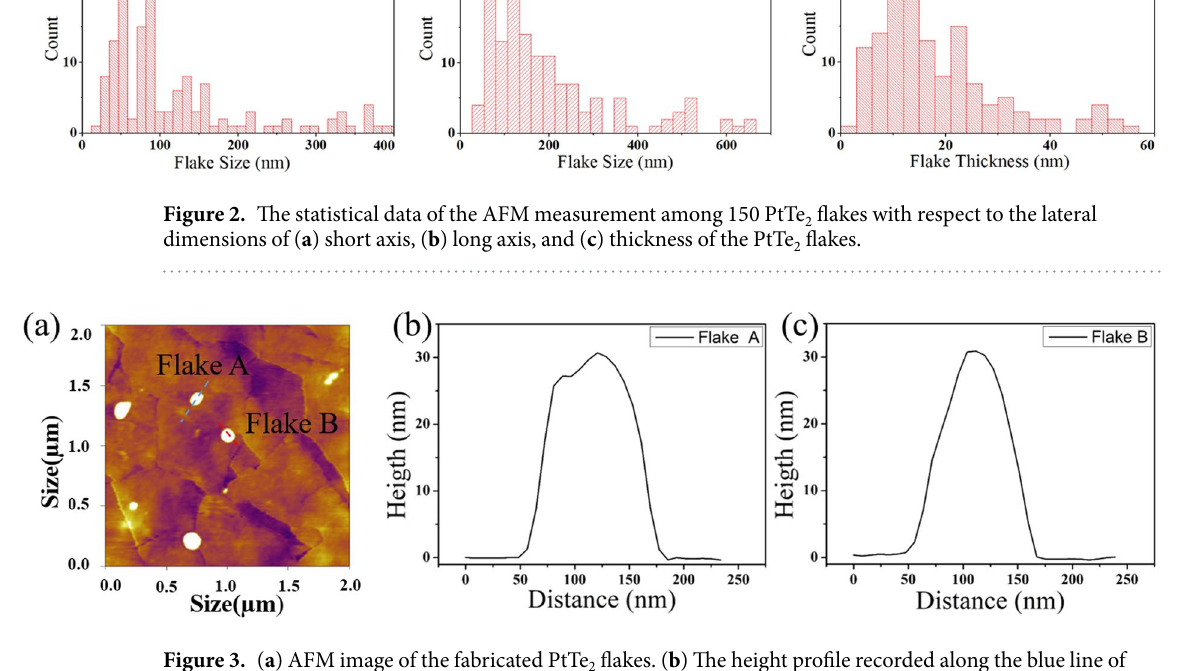
Figure 3. ( a ) AFM image of the fabricated PtTe 2 flakes. ( b ) The height profile recorded along the blue line of flake A and ( c ) the red line of flake B shown in ( a ).